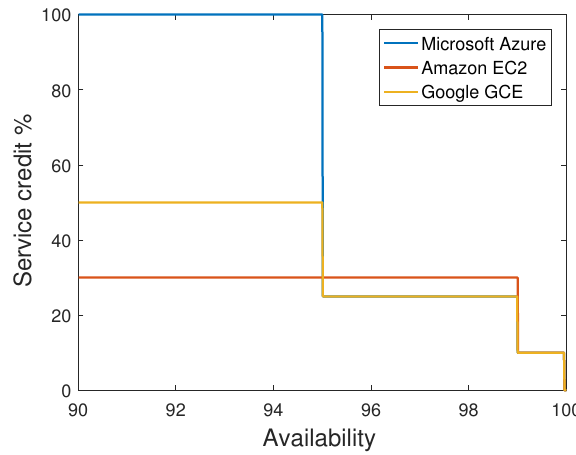
Figure 1. Comparison of three service credit functions in availability.